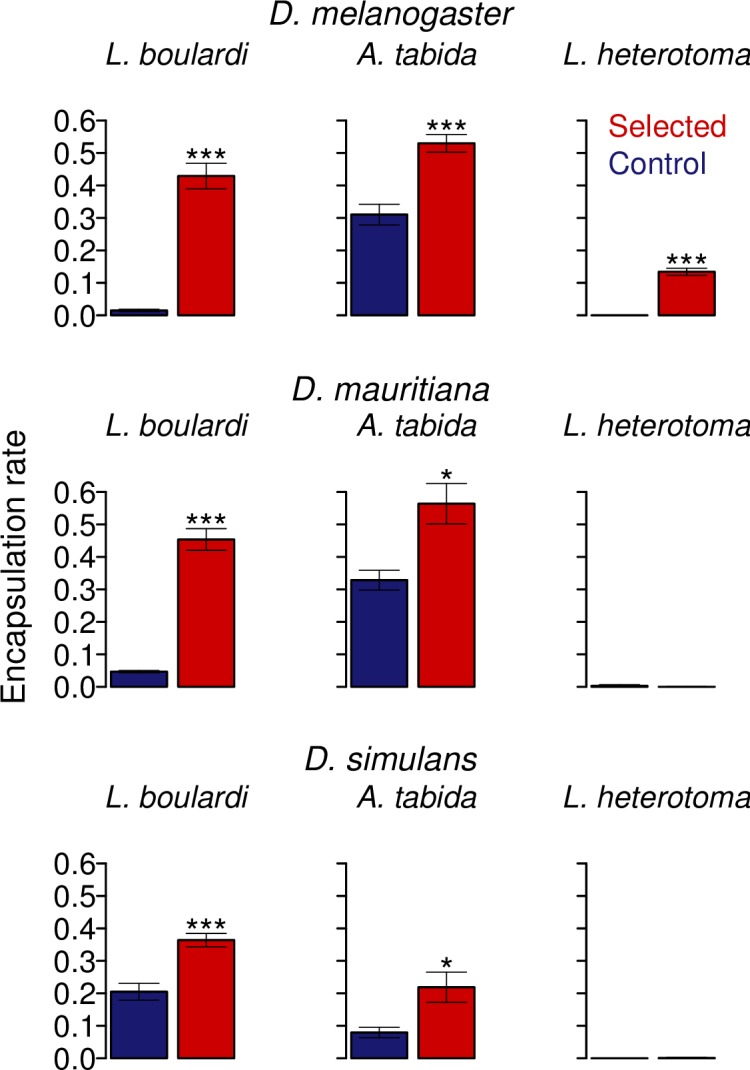
Mean encapsulation rates of selected and control populations challenged with three different parasitoid wasp species.Stars denote the degree of significance of between selected and control populations: * = p <0.05 and *** = p <0.001. Bars are equal to 1 SE. No. of replicate vials per replicate population = 15 for each parasitoid assayed.